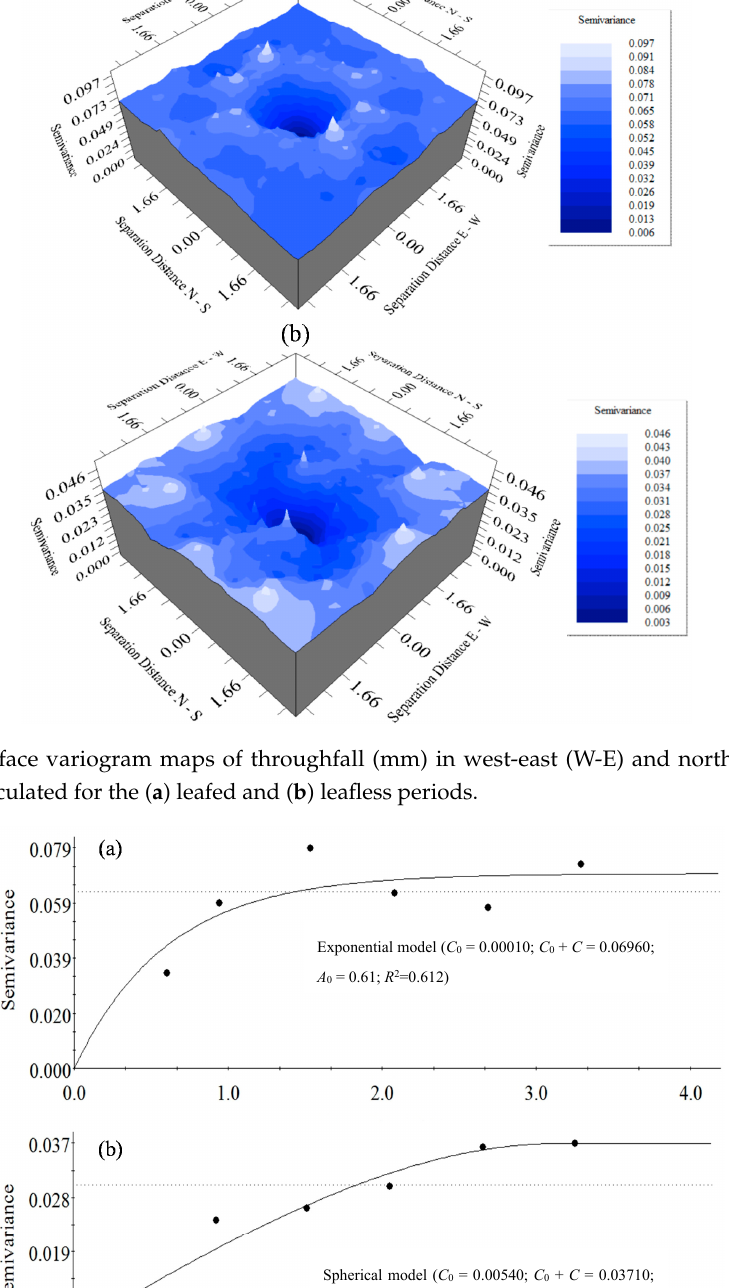
Figure 4. Experimental isotropic semivariograms for throughfall (mm) and fitted models for the ( a ) leafed and ( b ) and leafless periods. C 0 = Nugget effect, C = Sill, A 0 = Range parameter.